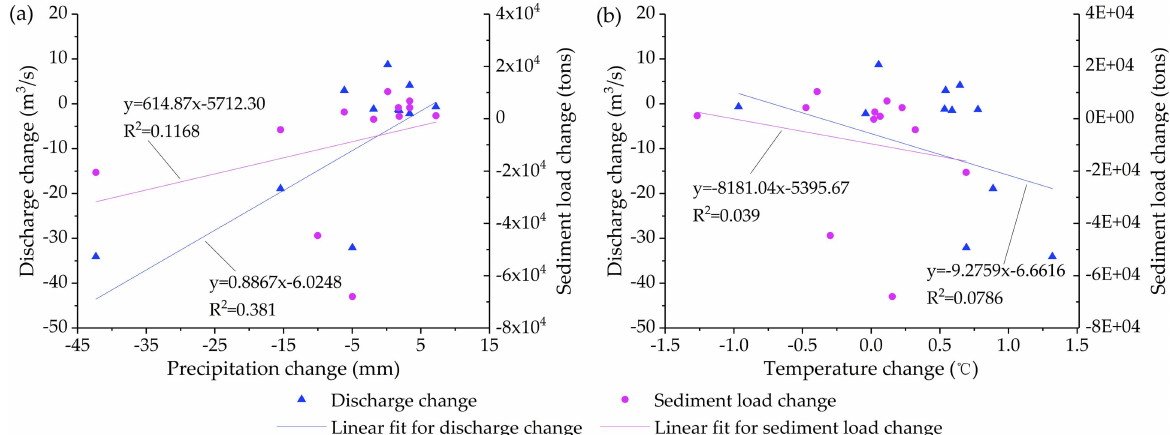
Figure 5. Correlations between the variations of climate variables (i.e., precipitation and temperature) and hydrological variables (i.e., discharge and sediment load) at a monthly scale: ( a ) correlation between the variations of precipitation and hydrological variables; ( b ) correlation between the variations of temperature and hydrological